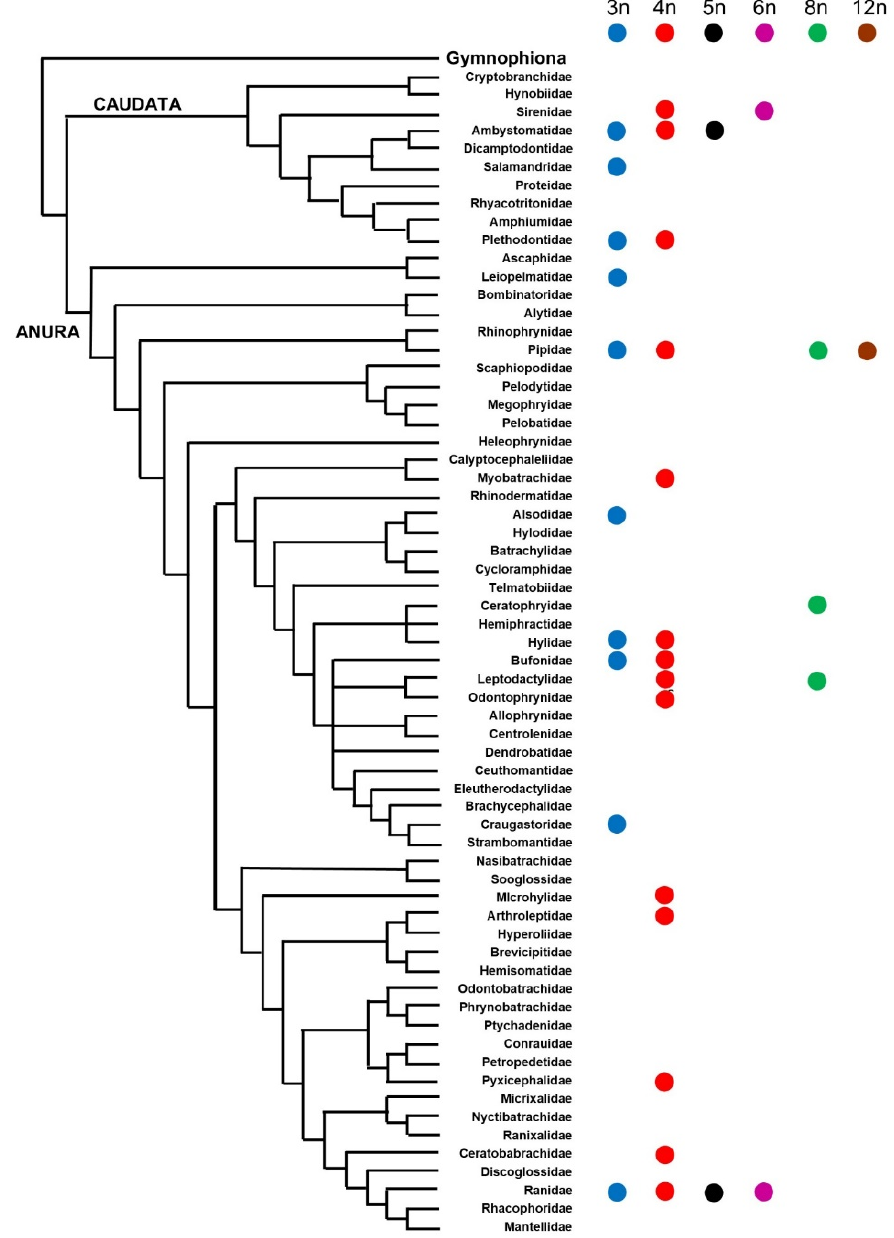
Figure 2. Phylogenetic distribution of polyploidy in Amphibia. Phylogenetic relationships redrawn from [34] and based on different datasets [35–39].